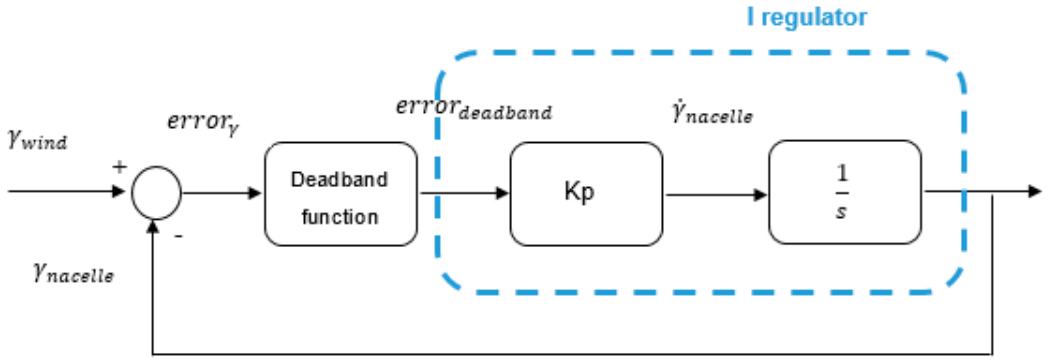
Figure 7. Block diagram of the conventional wind turbine yaw control of the I regulator.